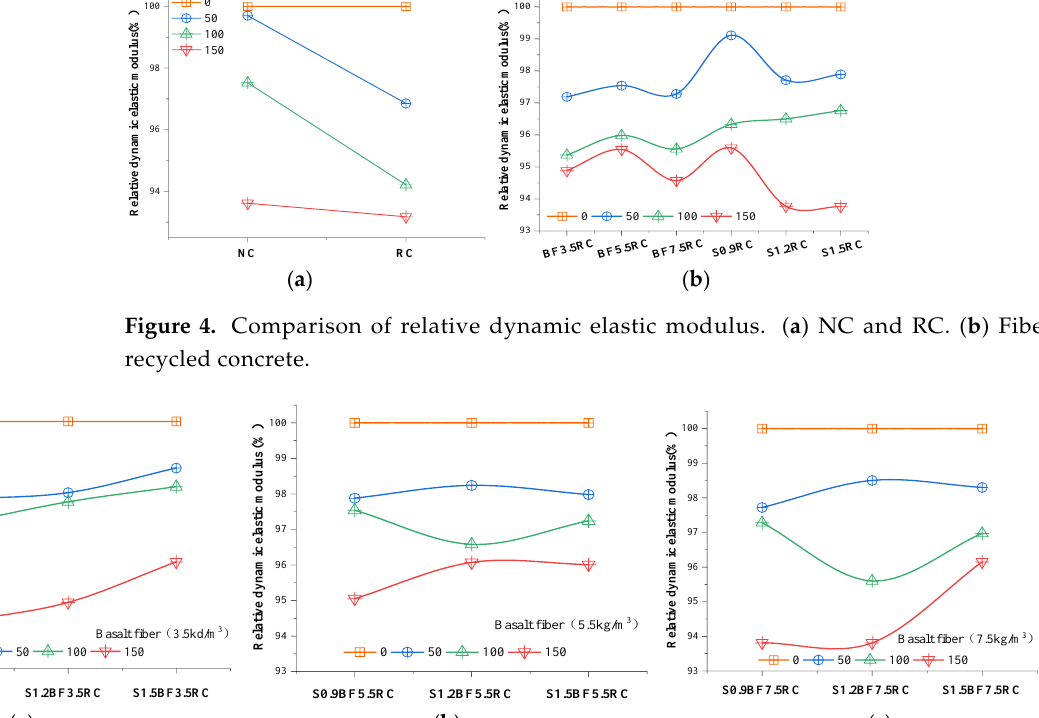
Figure 3. ( a – c ) Mass loss rate of steel–basalt fiber recycled concrete. ( d ) The cumulative mass loss rate.